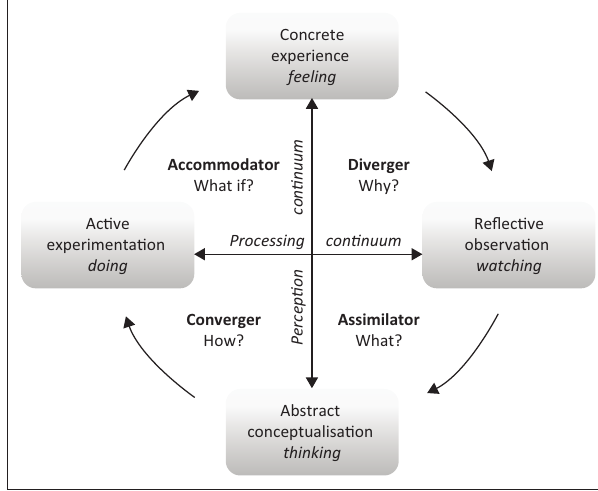
FIGURE 1: Kolb’s experiential learning model and learning